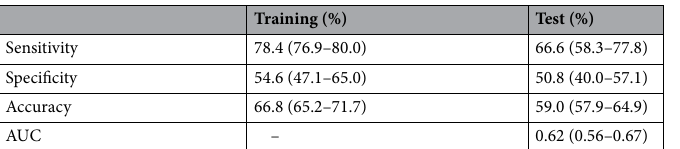
Table 5. Assessment of the predictive performance of the predictive model for training and testing data in the whole-lung radiomics analysis without the synthetic minority over-sampling technique. AUC, area under the curve.